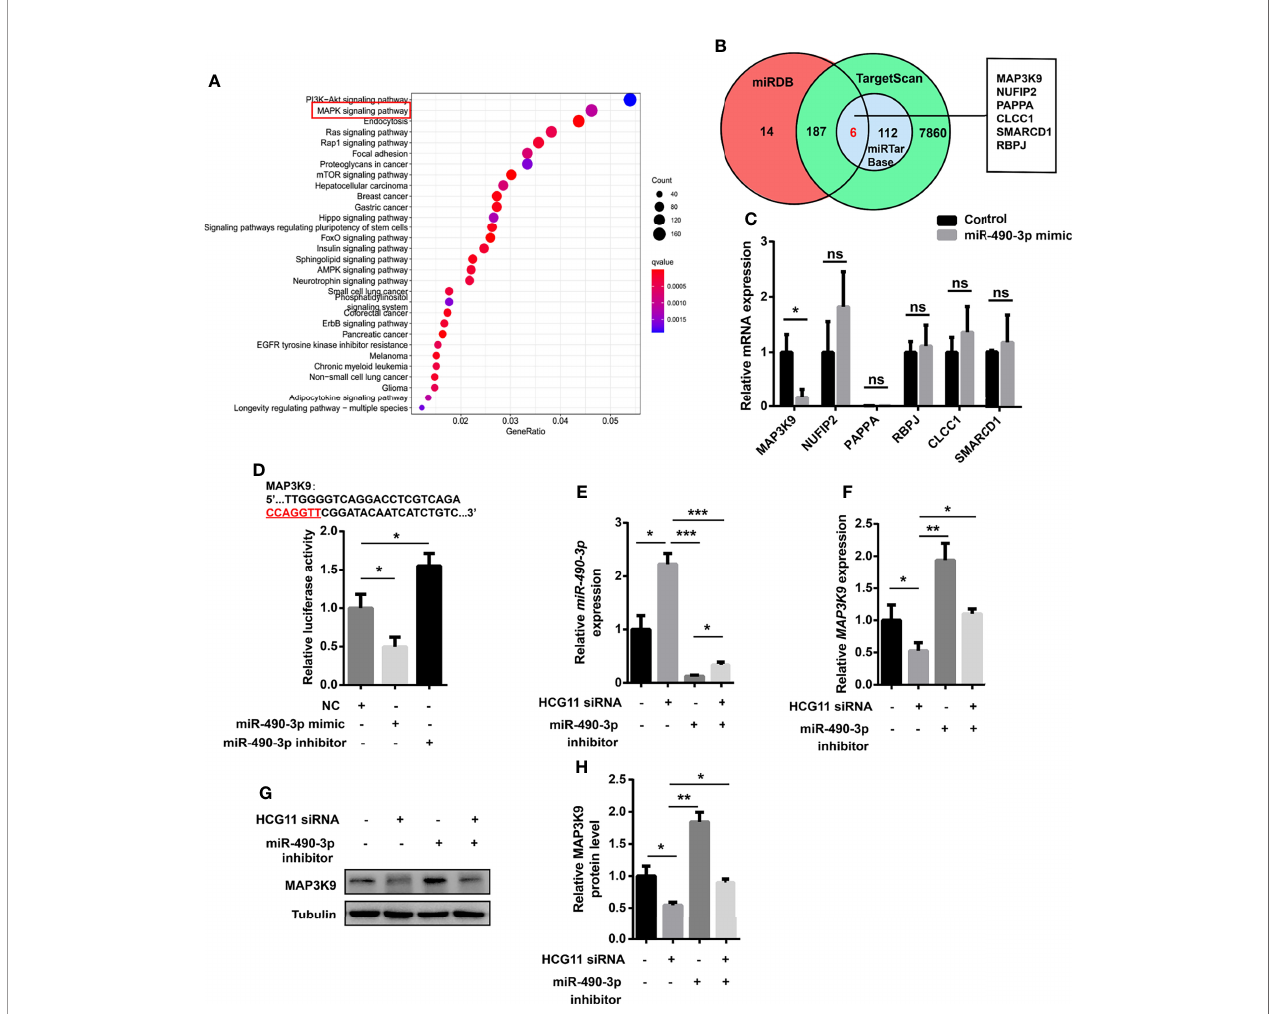
FIGURE 7 | HCG11 regulates NPC cells via miR-490-3p/MAP3K9 signaling. (A) KEGG pathway enrichment analysis of target mRNAs downstream of miR-490-3p were shown. (B) Venn diagram analysis of miR-490-3p related genes was listed. (C) Q-PCR analysis of gene expression in 5-8F cells transferred with control or miR- 490-3p mimic. (D) 5-8F cells were co-transfected with PGL3-CMV-LUC-MAP3K9 and miR-490-3p mimic or miR-490-3p inhibitor. Luciferase activity of MAP3K9 was determined. (E, F) Q-PCR analysis of miR-490-3p (E) and MAP3K9 (F) in 5-8F cells transferred with miR-490-3p inhibitor or HCG11 siRNA. (G, H) The protein expression of MAP3K9 was con fi rmed in 5-8F cells transferred with miR-490-3p inhibitor or HCG11 siRNA. Data were presented as Mean ± SEM. Ns, p > 0.05, * p < 0.05, ** p < 0.01, *** p < 0.001. These experiments were repeated for three times (C – H)